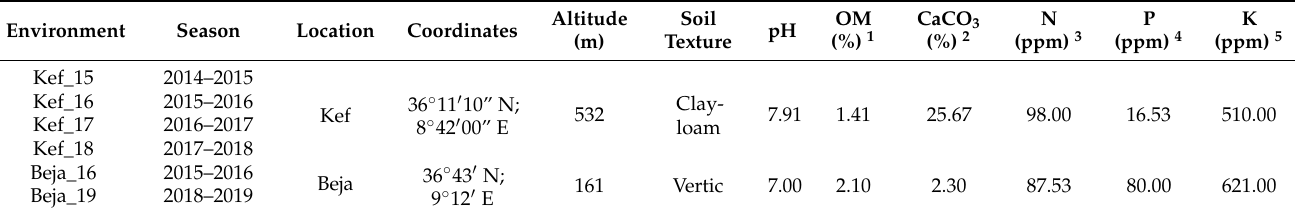
Table 2. Description of the tested environments in Kef and Beja